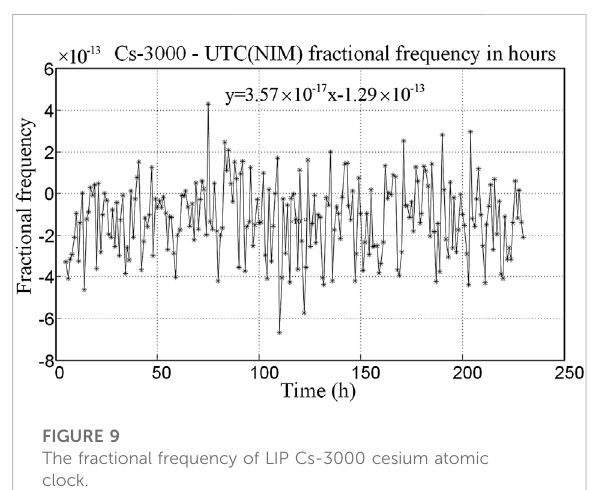
FIGURE 8 The Allan deviation data of LIP Cs-3000 atomic clocks. Cs nn – LIP Cs-3000 clocks. The dotted lines are corresponding to